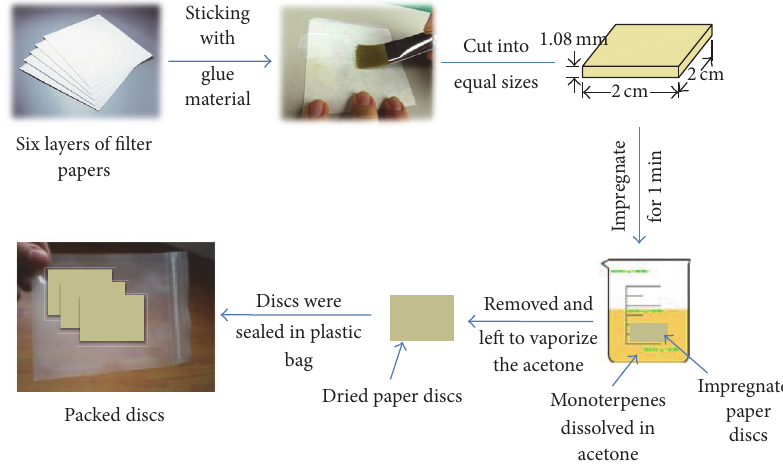
Figure 3: Schematic illustration of the preparation paper mosquito repellent incense .